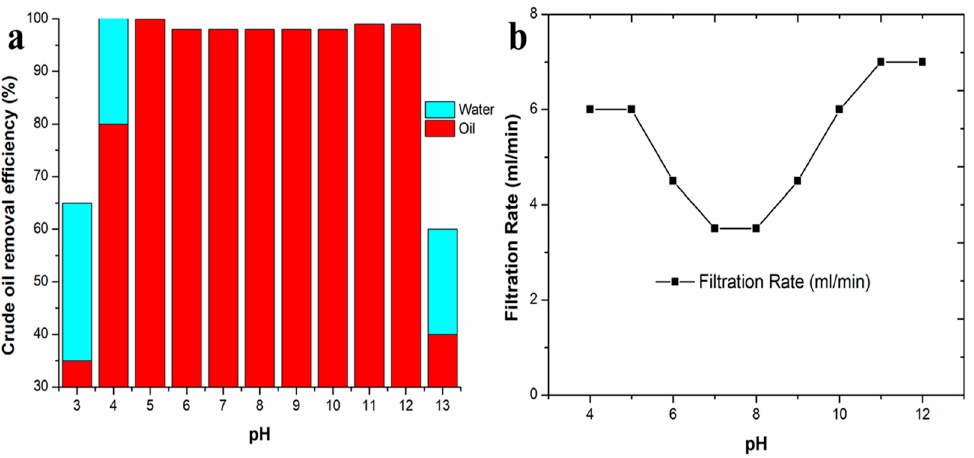
Figure 9. E ff ect of pH on the ( a ) oil removal e ffi ciency and ( b ) filtration rate, operating condition Figure 9. Effect of pH on the ( a ) oil removal efficiency and ( b ) filtration rate, operating condition O/W O / W = 20 / 80, HPAM = 50 ppm, shear rate = 5000 = 20/80, HPAM = 50 ppm, shear rate = 5000 rpm.